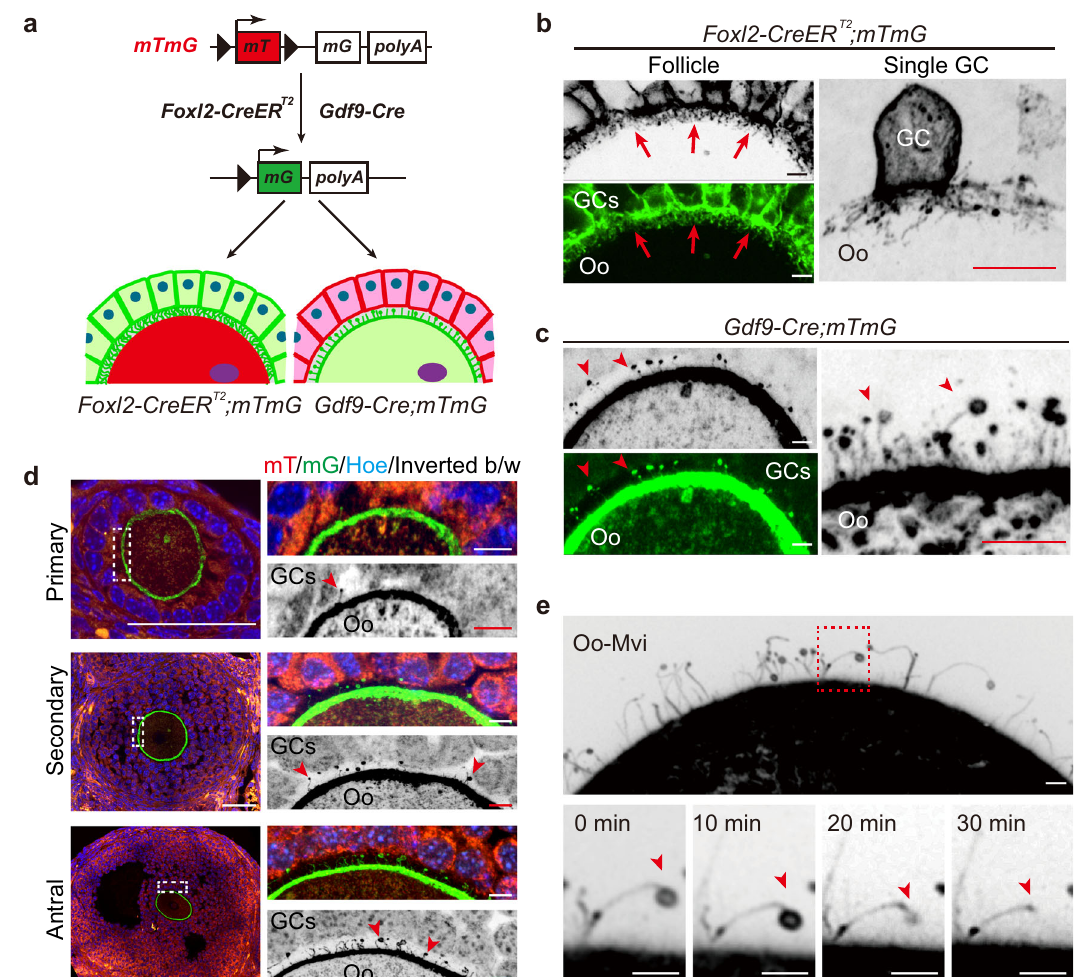
Fig. 1 Imaging cell-speci fi c communicating structures in the ZP by endogenous- fl uorescent labeling in follicles. a Illustration of the strategy to label the derivation of the cellular communicating structures in the ZP by cellular speci fi cally expressed CreER T2 or Cre recombinase. Membrane-localized red- fl uorescent protein (mT) switches to green- fl uorescent protein (mG) in GCs of Foxl2-CreER T2 ;mTmG follicles and oocytes of Gdf9-Cre;mTmG follicles. b Images of Foxl2-CreER T2 ;mTmG ovarian sections showing the high density of GC-TZPs (arrows), and labeling of a single GC showing the messy tree root- like structure of GC-TZPs in detail (right). c Images of Gdf9-Cre;mTmG ovarian sections, the mushroom-like Oo-Mvi (arrowheads) distributed in a low density (left) and high magni fi cation showing the vesicle tips (arrowheads) of Oo-Mvi (right). d The developmental dynamics of Oo-Mvi (arrowheads), showing the establishment of Oo-Mvi accompanied by follicle growth. e Time-lapse imaging of Oo-Mvi in living oocytes showing the breakdown of vesicles (arrowheads) of Oo-Mvi (Supplementary Movie 3). All experiments were repeated at least three times, and representative images are shown. Oo oocyte. GCs granulosa cells. ZP zona pellucida. b – e The colors were inverted to black/white (b/w) to highlight GC-TZPs ( b ) and Oo-Mvi ( c – e ). Scale bars: 5 μ m ( b – d ) and 2 μ m ( e